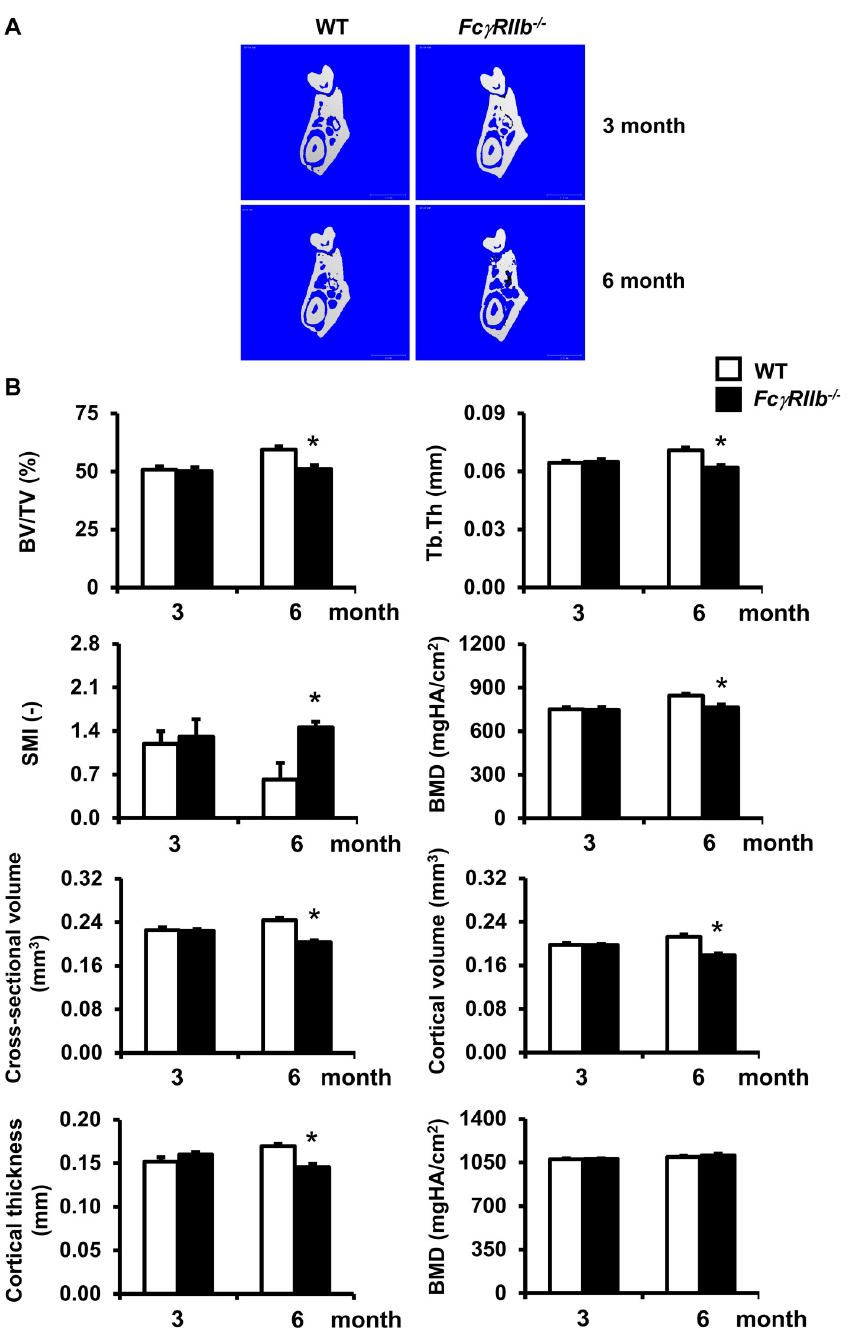
Fig 1. Deletion of Fc γ RIIb induces cancellous and cortical bone loss in mandibles in 6- but not 3-month-old males. (A) Representative μ CT images of mandibular bone from 3- and 6-month-old Fc γ RIIb -/- mice and WT controls. (B) μ CT analysis of cancellous and cortical bone in the mandibles from 3- and 6-month-old Fc γ RIIb -/- mice and WT controls. Data are mean ± SEM (n = 7–8). � p < 0.05 versus WT